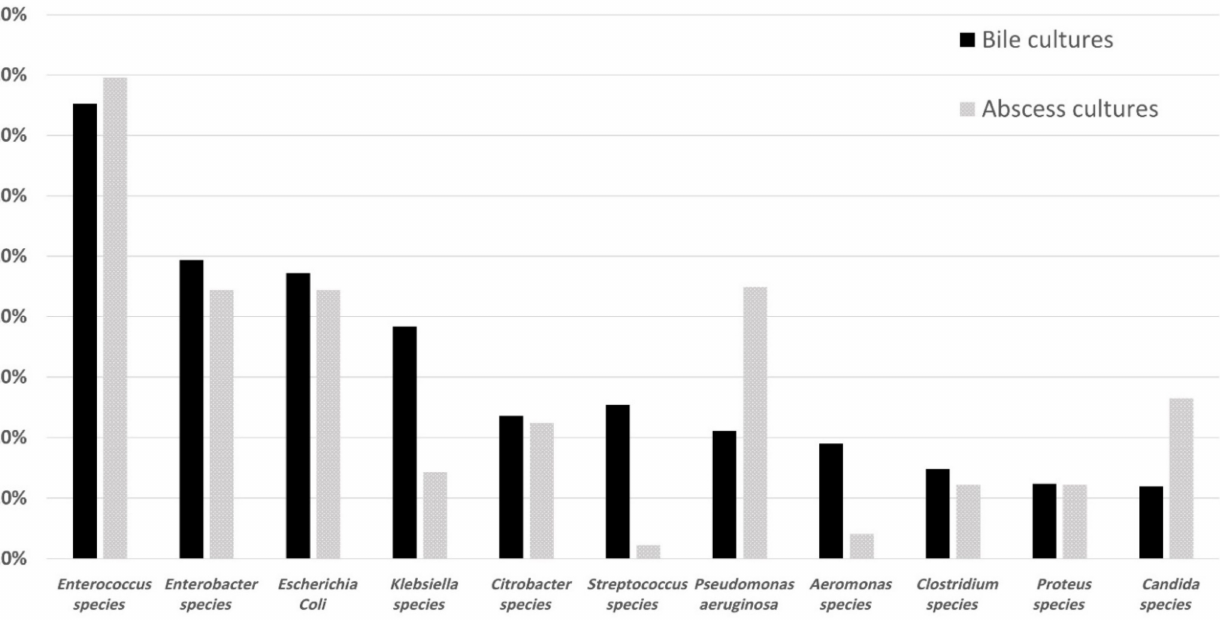
Figure 1. Comparison of microorganisms grown in intraoperative bile cultures between different PBD.